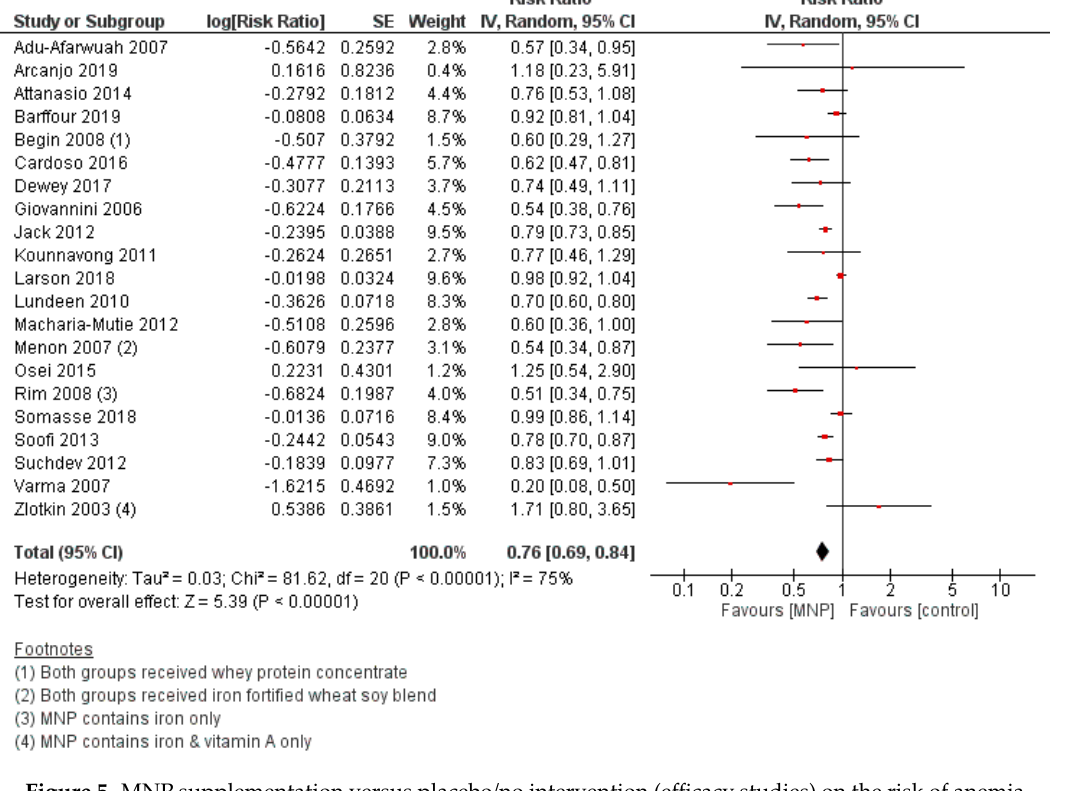
Figure 5. MNP supplementation versus placebo/no intervention (efficacy studies) on the risk of anemia (hemoglobin concentration < 110 g/L).